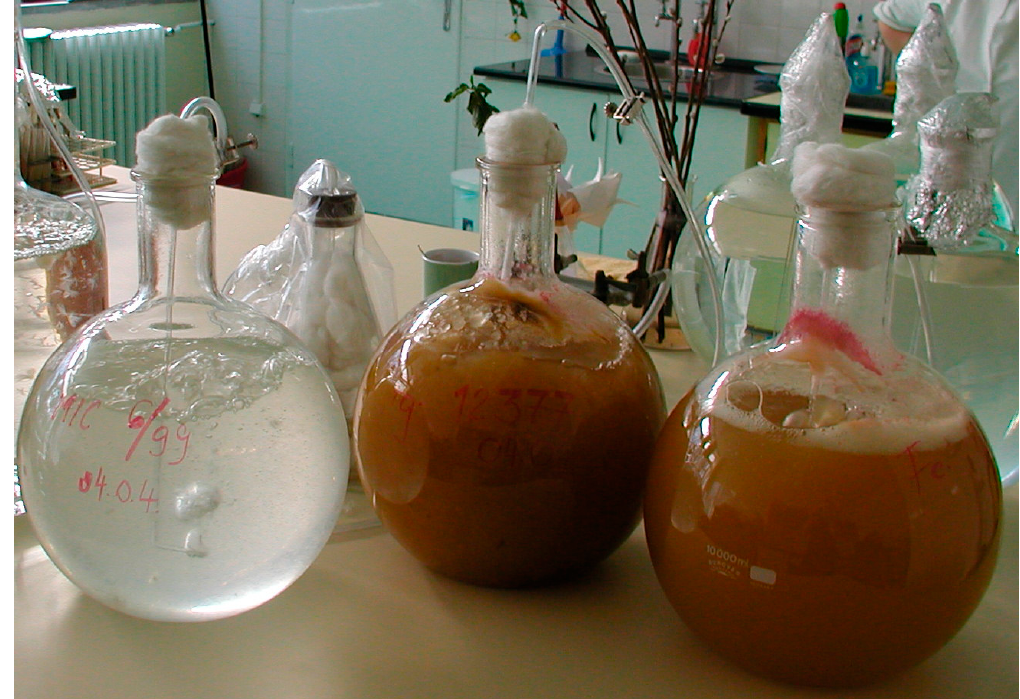
Figure 12. Bubble-breeding (BB) method for inoculum production. Left: A young inoculum 2–3 days old, right: Ready inocula for use before terminating the breeding.